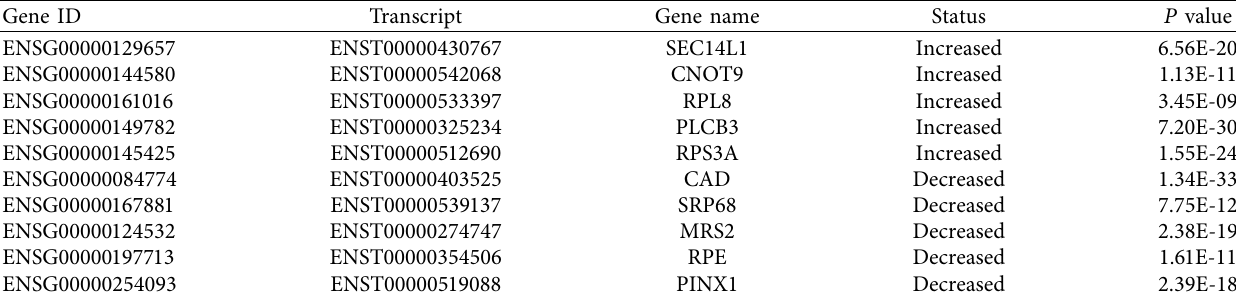
Table 3: Top 5 increased and decreased